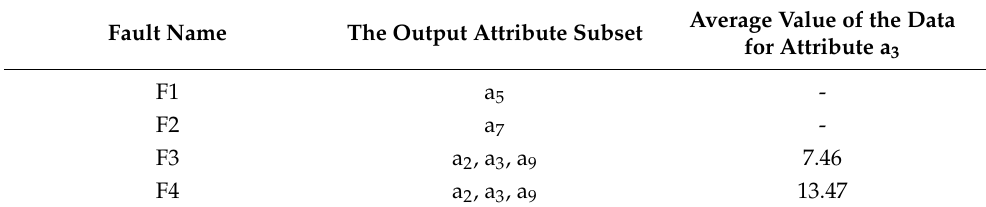
Table 9. The results of the training